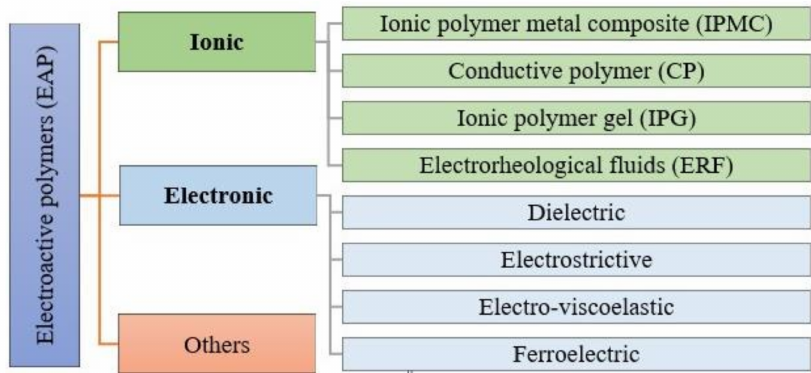
Figure 1. Different types of electroactive polymers.